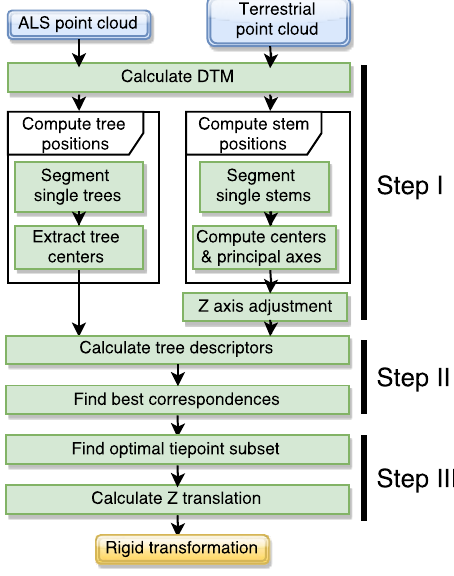
Figure 1: Overview of coregistration